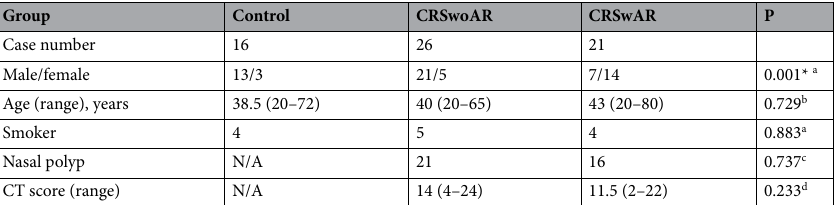
Table 1. Clinical characteristics of study subjects. CRSwoAR, chronic rhinosinusitis without allergic rhinitis; CRSwAR, chronic rhinosinusitis with allergic rhinitis; CT, computed tomography. a Chi-square test. b